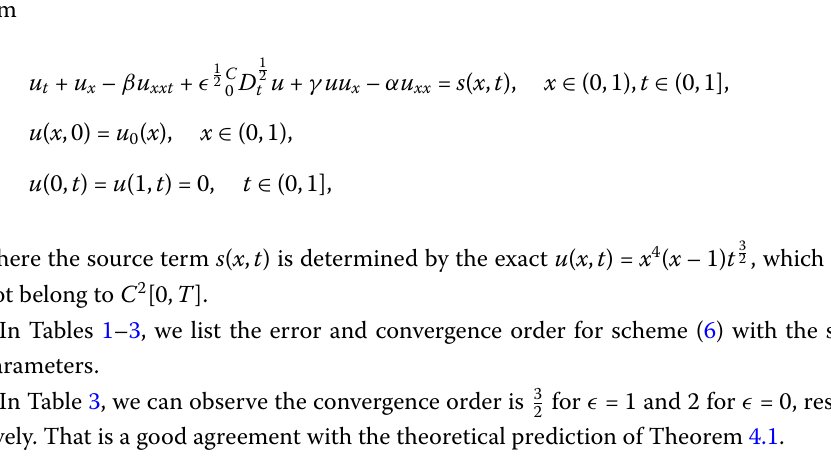
Table 1 Error and convergence order in time when h = 1/1000, (cid:4) = α = β = γ = 1 τ (cid:10) e (cid:10) Order (cid:10) e (cid:10) ∞